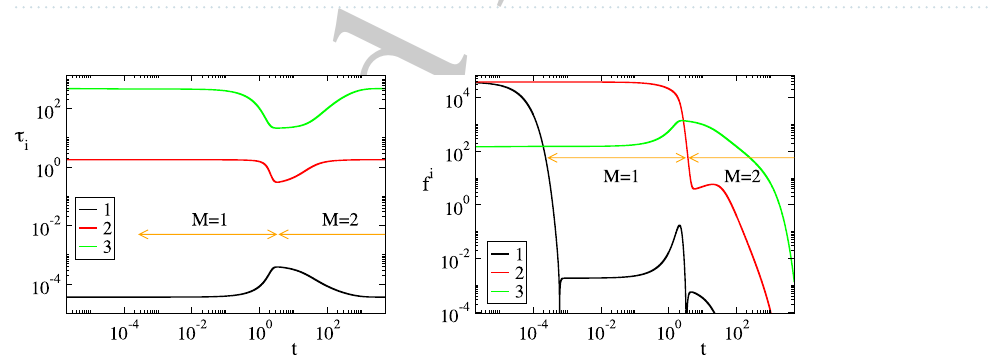
. FcRn IgG IgG FcRn C IgG e , C e . p , C e and